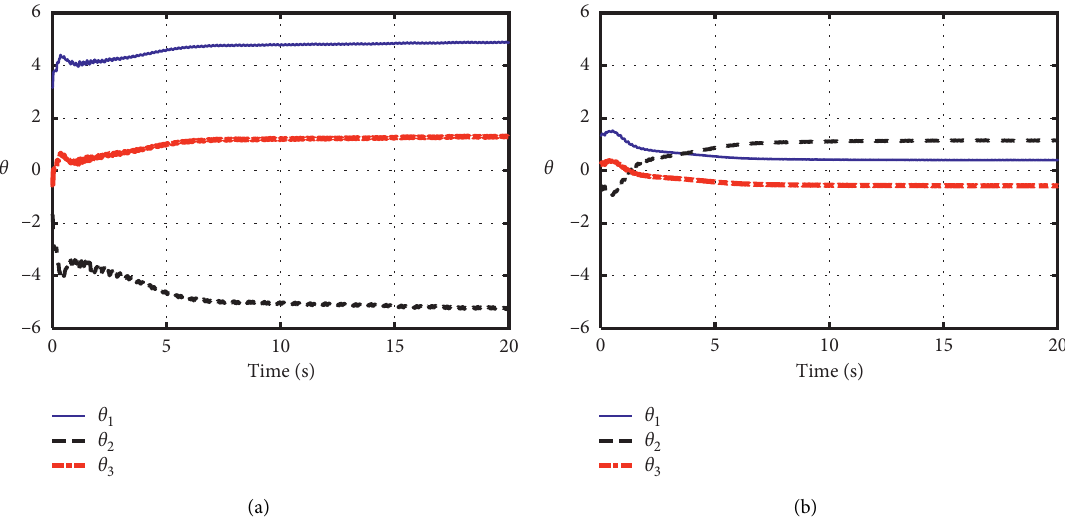
Figure 10: Time histories of estimated parameters with sinusoidal excitation. (a) The SADC method. (b) The TADC method.